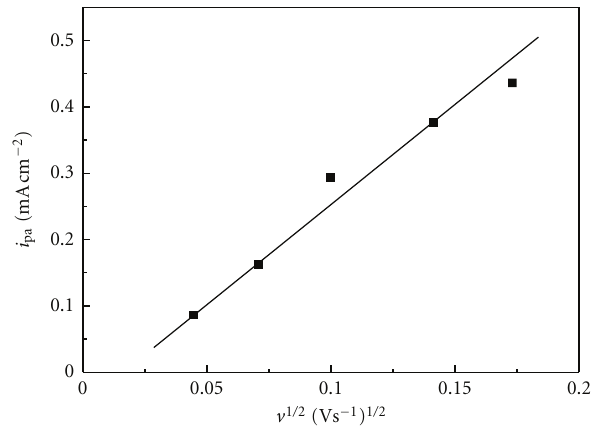
Figure 5: A plot of the anodic peak currents against square root of the scan rates for the striping of Mg on platinum disk electrode from 0.3 molL − 1 Mg(CF 3 SO 3 ) 2 /BMImBF 4 + THF (6:1).